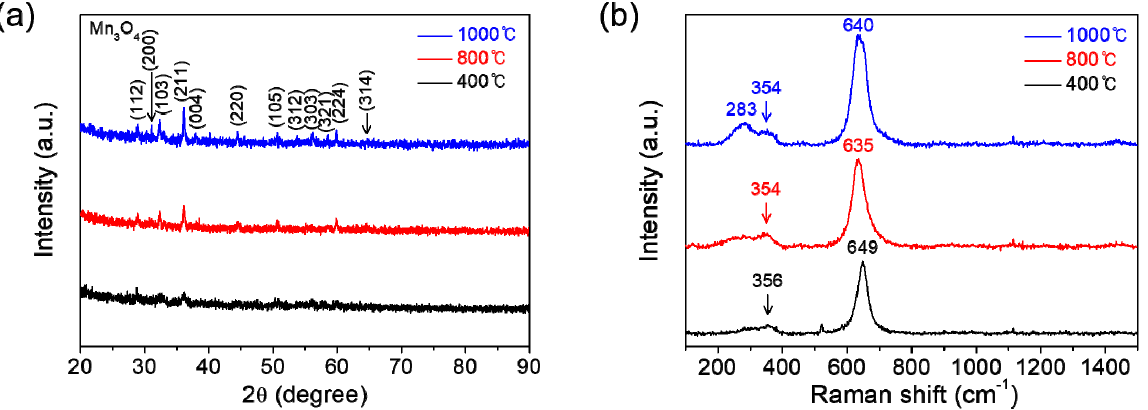
Figure 5. ( a ) XRD patterns and ( b ) Raman spectra of the manganese oxide (Mn 3 O 4 ) films prepared at various calcination temperatures of 400, 800, and 1000 °C for 1 h under an inert atmosphere of Ar.